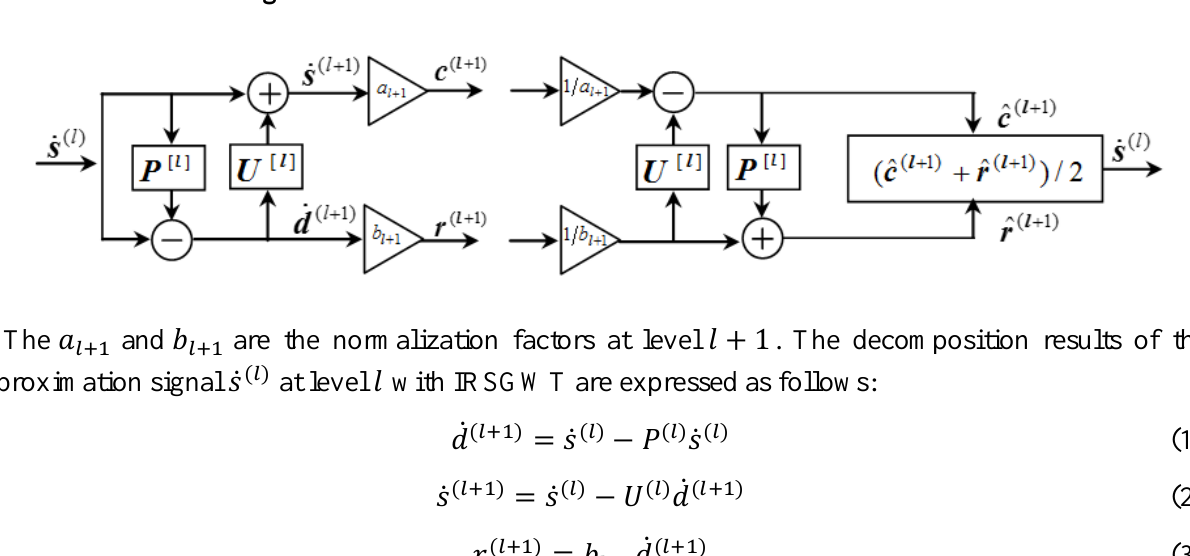
Figure 5. The forward and inverse transform of